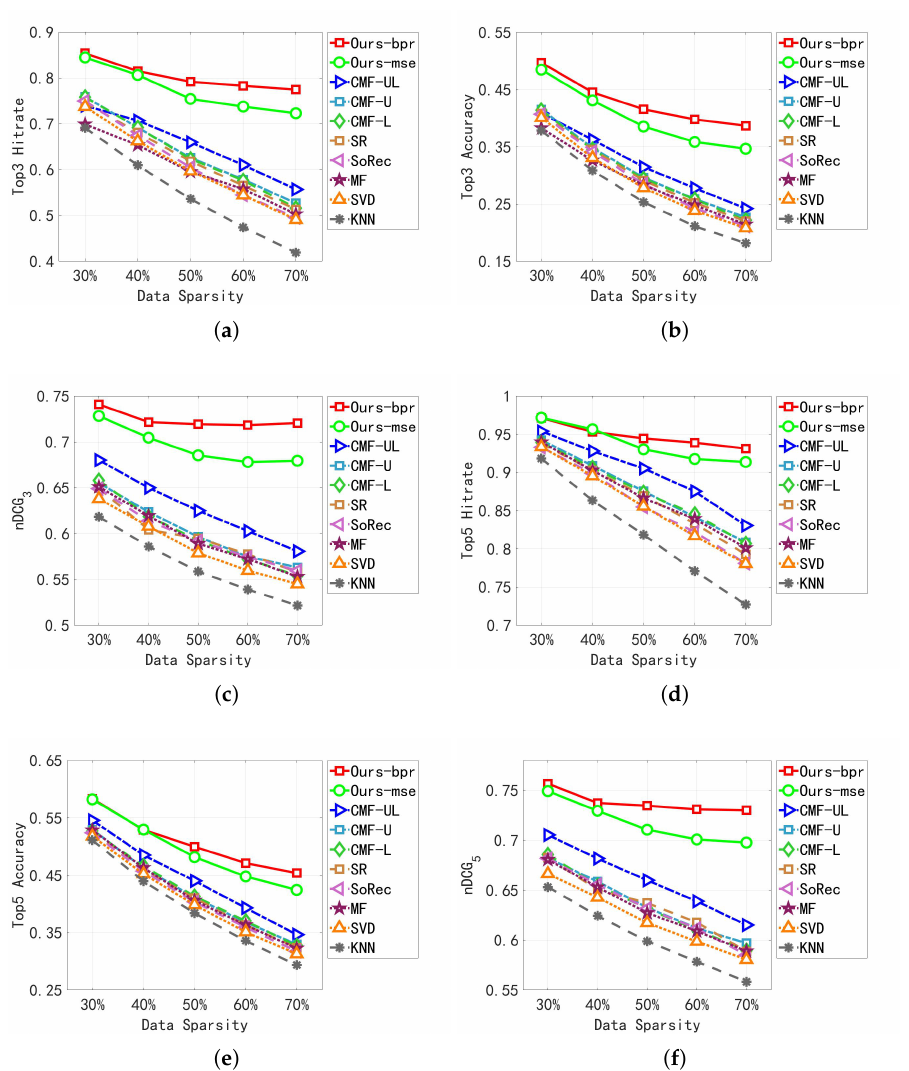
Figure 4. Comparisons of the Recommendation Performances on Telecom Dataset under Different Sparsity Levels. ( a ) Top 3 Hitrate . ( b ) Top 3 Accuracy . ( c ) nDCG 3 . ( d ) Top 5 Hitrate . ( e ) Top 5 Accuracy . ( f ) nDCG 5